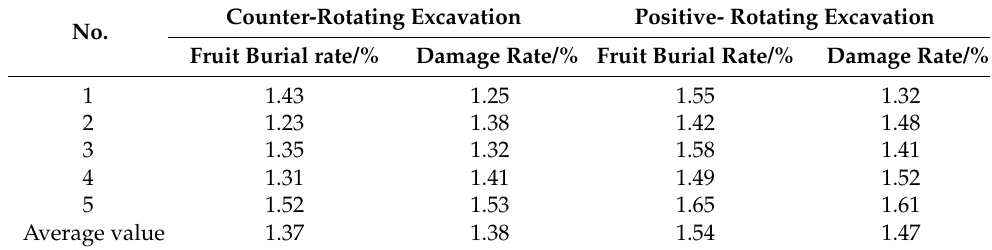
Table 9. Field trial